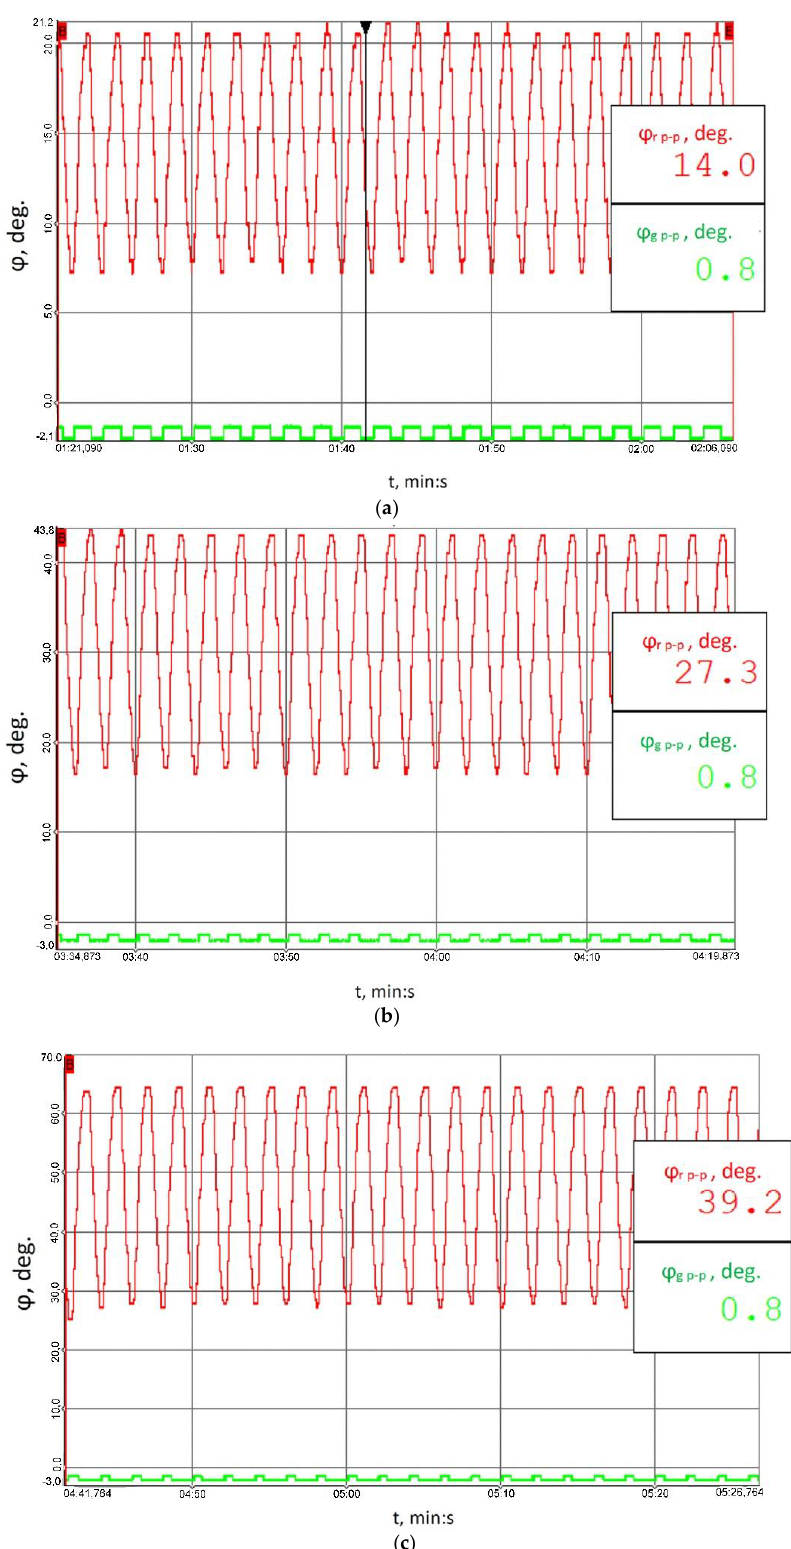
Figure 10. Recorded time histories of the torsional angle of the clutch members for the following load scenarios: ( a ) 41.8 ± 27.9 Nm, ( b ) 79.2 ± 55 Nm, ( c ) 114.8 ± 75.9 Nm; red colour marks the results obtained for the flexible operation mode of the clutch; green colour corresponds to the locked operation mode.